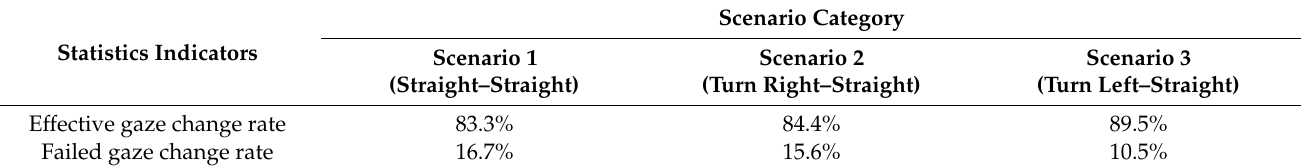
Table 7. The proportion of gaze changes in different